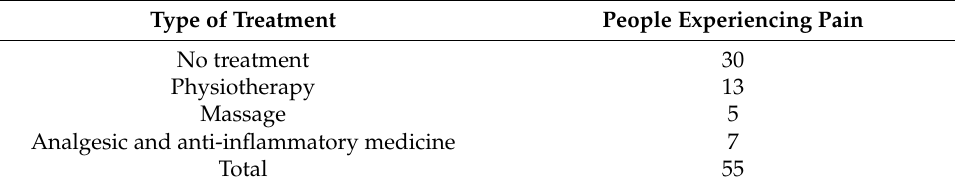
Table 5. Treatment sought by